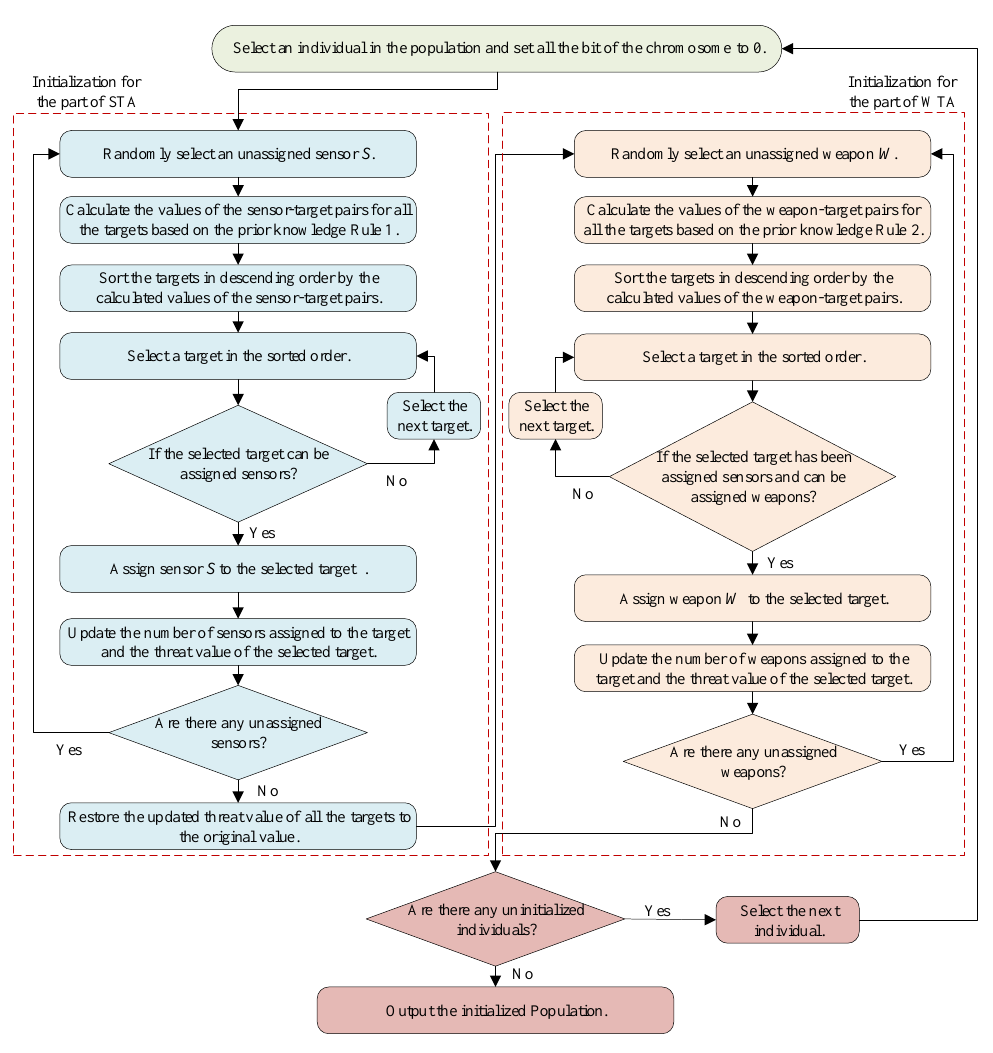
Figure 6. The flow chart of the proposed initialization